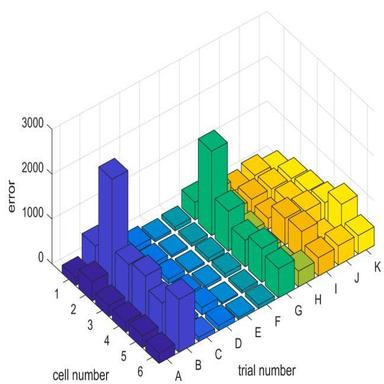
"Smoothness" expressed in terms of small error in various runs and cells considering the entire drying time.